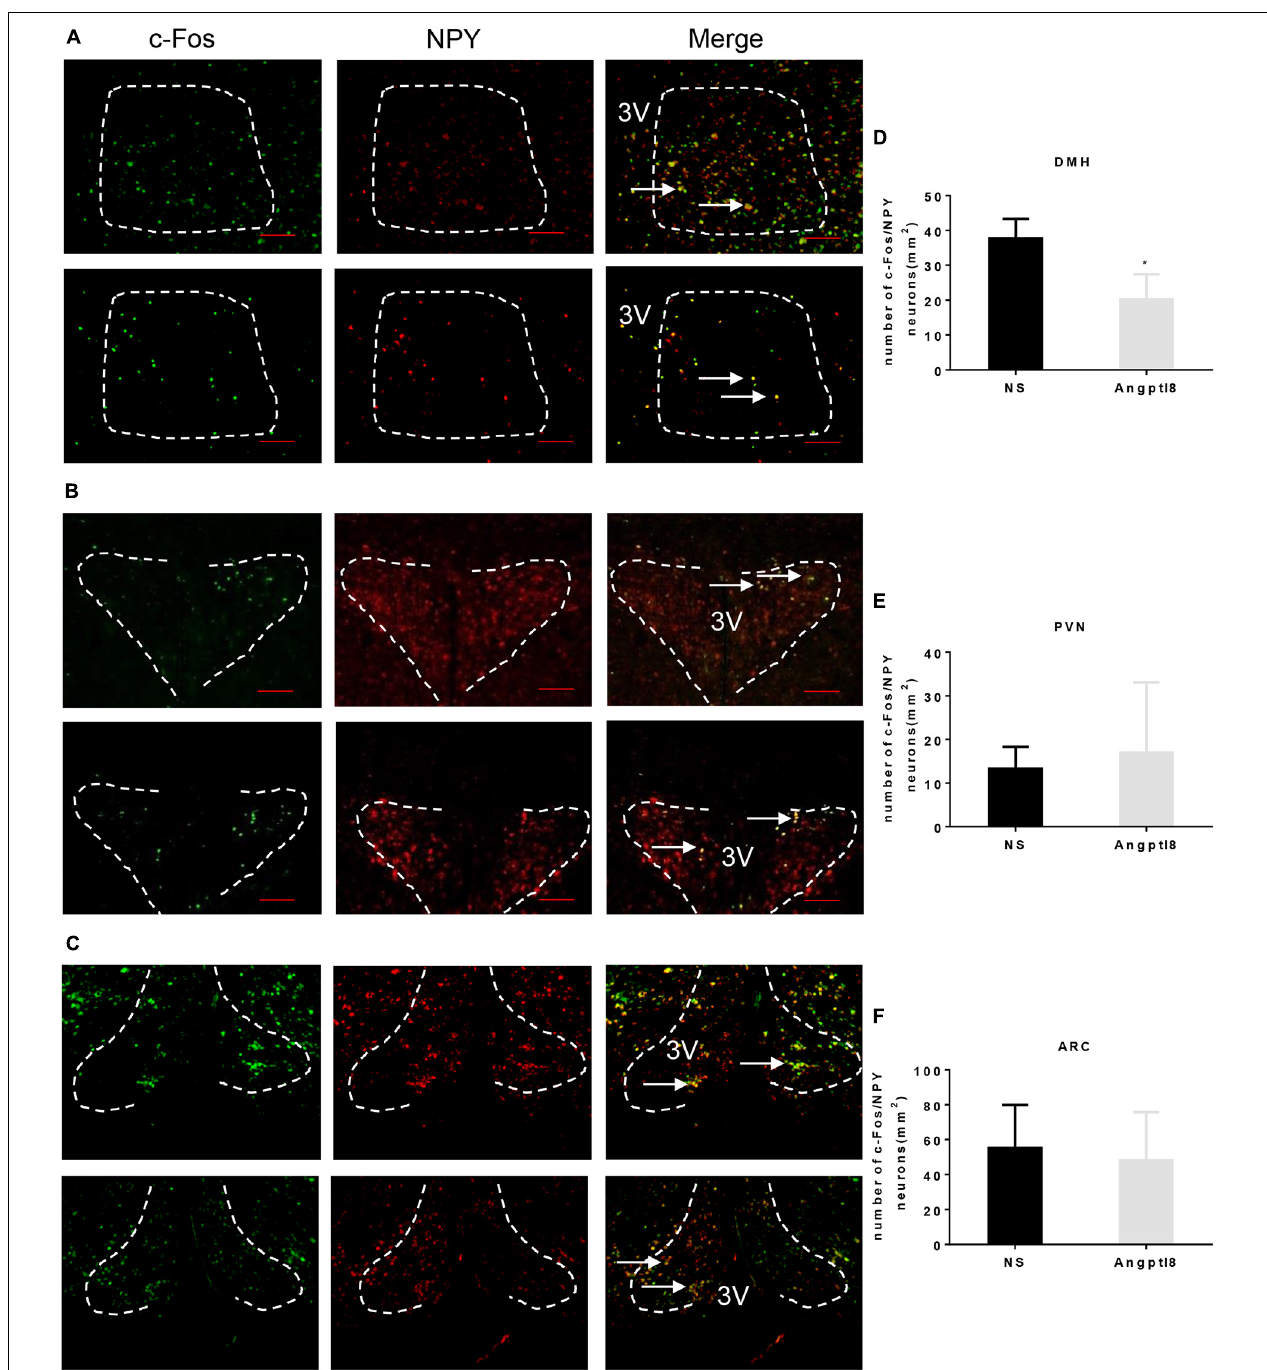
FIGURE 5 | Double staining of c-Fos and NPY in the hypothalamic PVN, DMH, and ARC after the I.C.V. injection of Angptl8. (A–C) Double-immunofluorescence images showed c-Fos immunoreactive cells (green) and NPY neurons (red) separately, and neurons with colocalization in the PVN, DMH, and ARC are depicted in yellow in the merged photograph. Scale bars = 200 µ m. (D–F) Colocalized neurons in the DMH ( n = 4), PVN ( n = 3), and ARC ( n = 3) were counted and are expressed as means ± SEM. ∗ P < 0.05 relative to the NS control group. Scale bar = 200 µ m → means colocalization of c-Fos and NPY